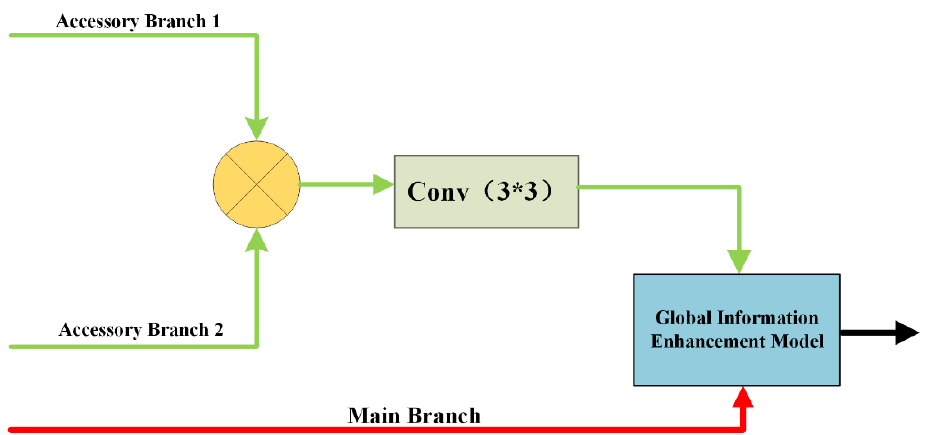
Figure 2. Feature-enhanced module.